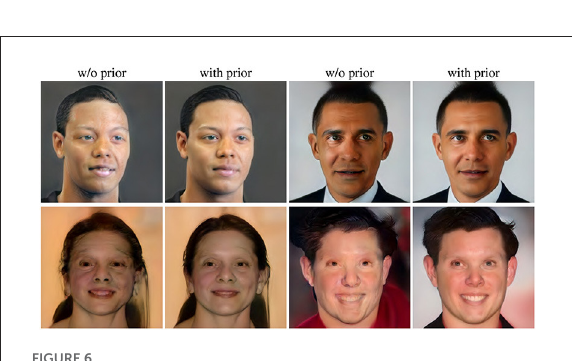
FIGURE6 Artifact reduction by imposing the Laplacian prior.